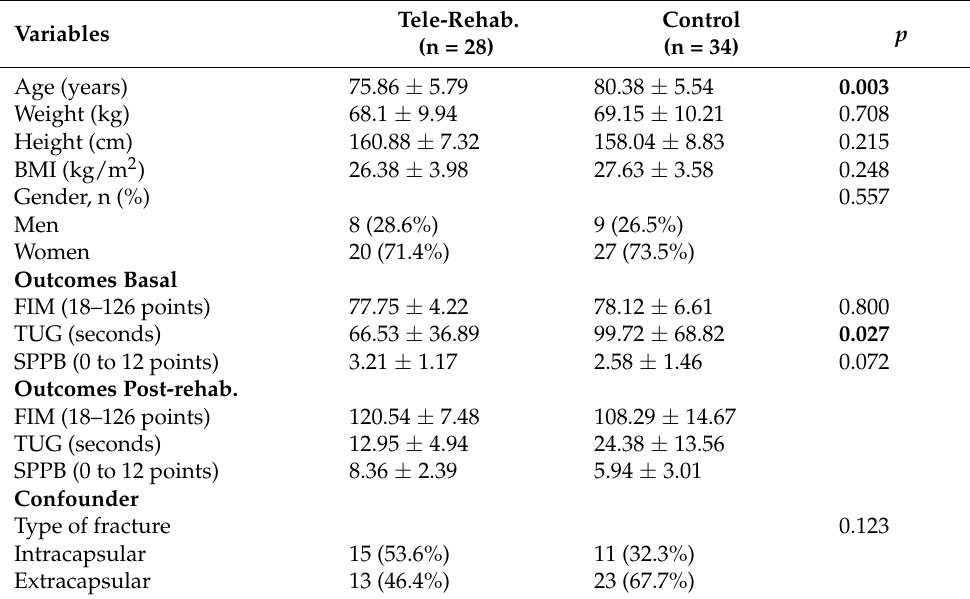
Table 1. Baseline characteristics and post-intervention raw values of sample divided by tele-rehabilitation (tele-rehab.) and control group.